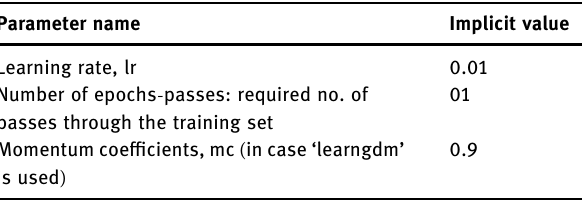
Table 3: Initialisation parameters for a learning procedure